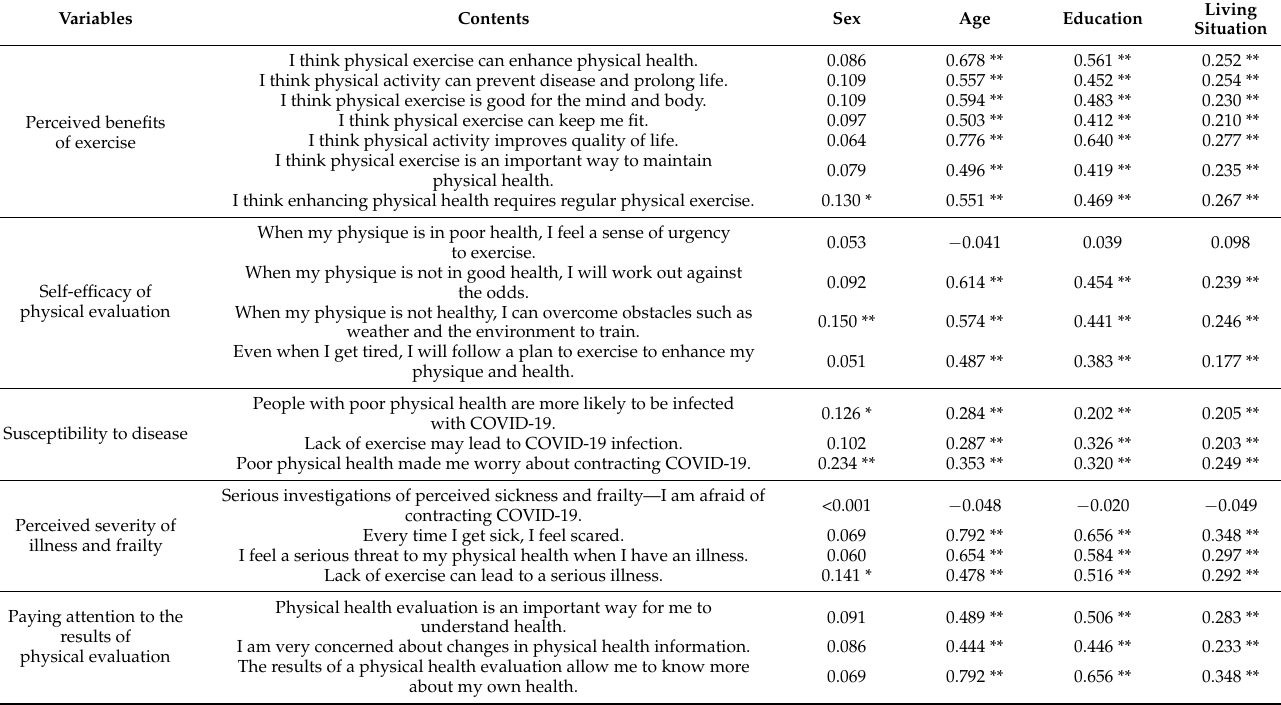
Table 3. Pearson correlation analysis of age, gender, and health beliefs ( n = 315).